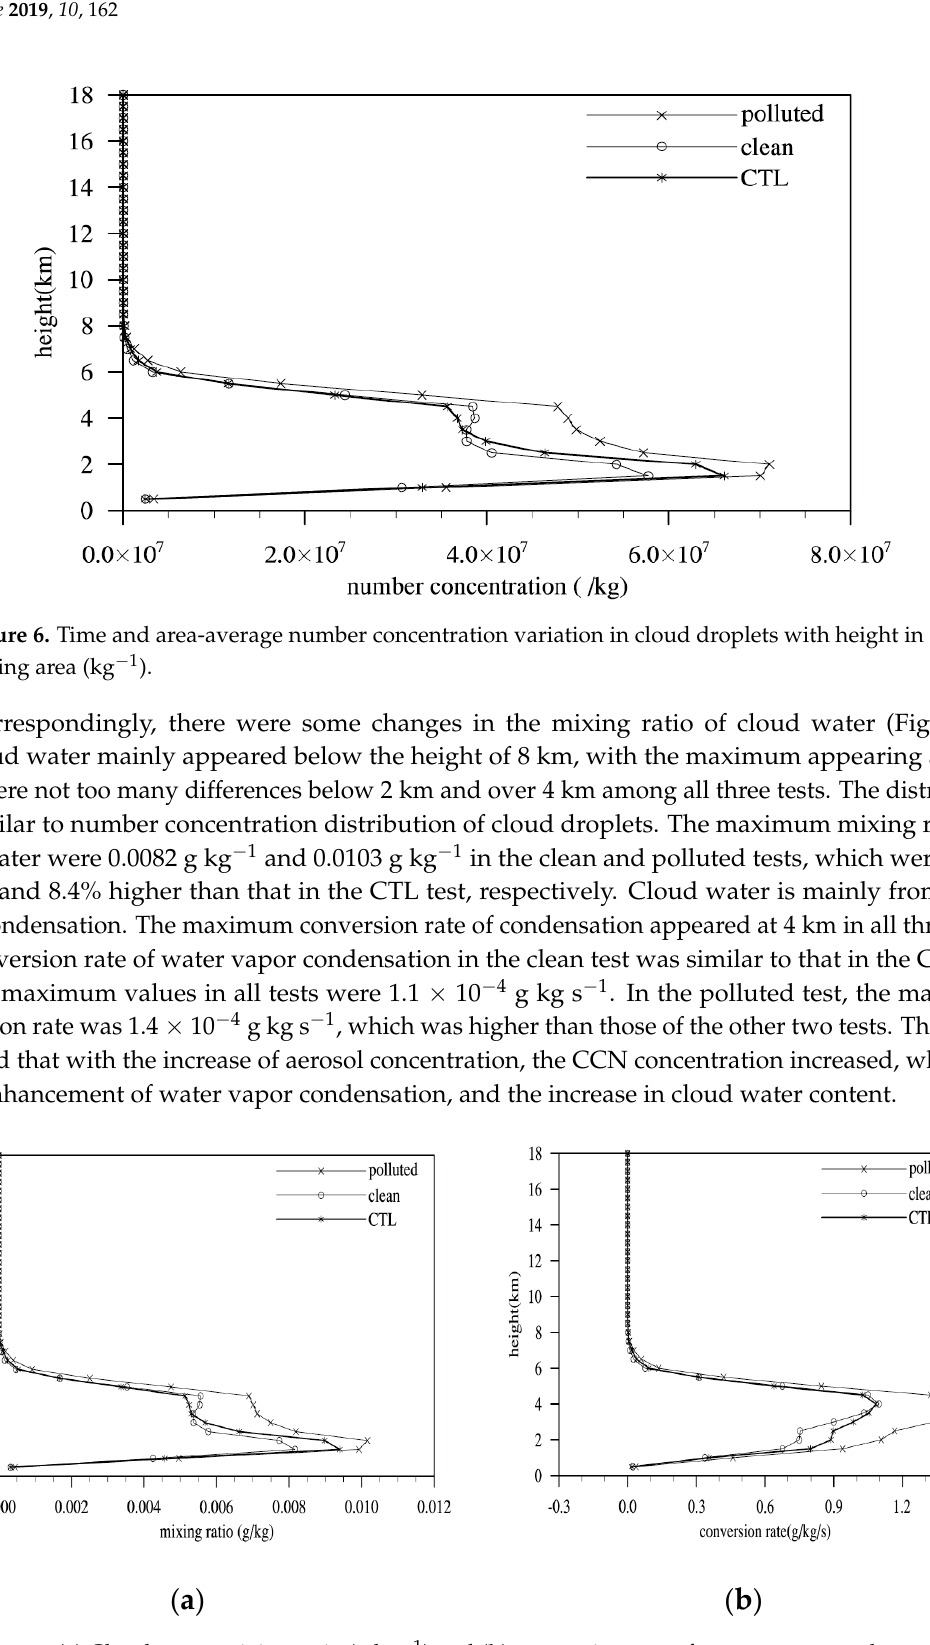
Figure 7. ( a ) Cloud water mixing ratio (g kg − 1 ) and ( b ) conversion rate of water vapor condensation (10 − 4 g kg − 1 s − 1 ).